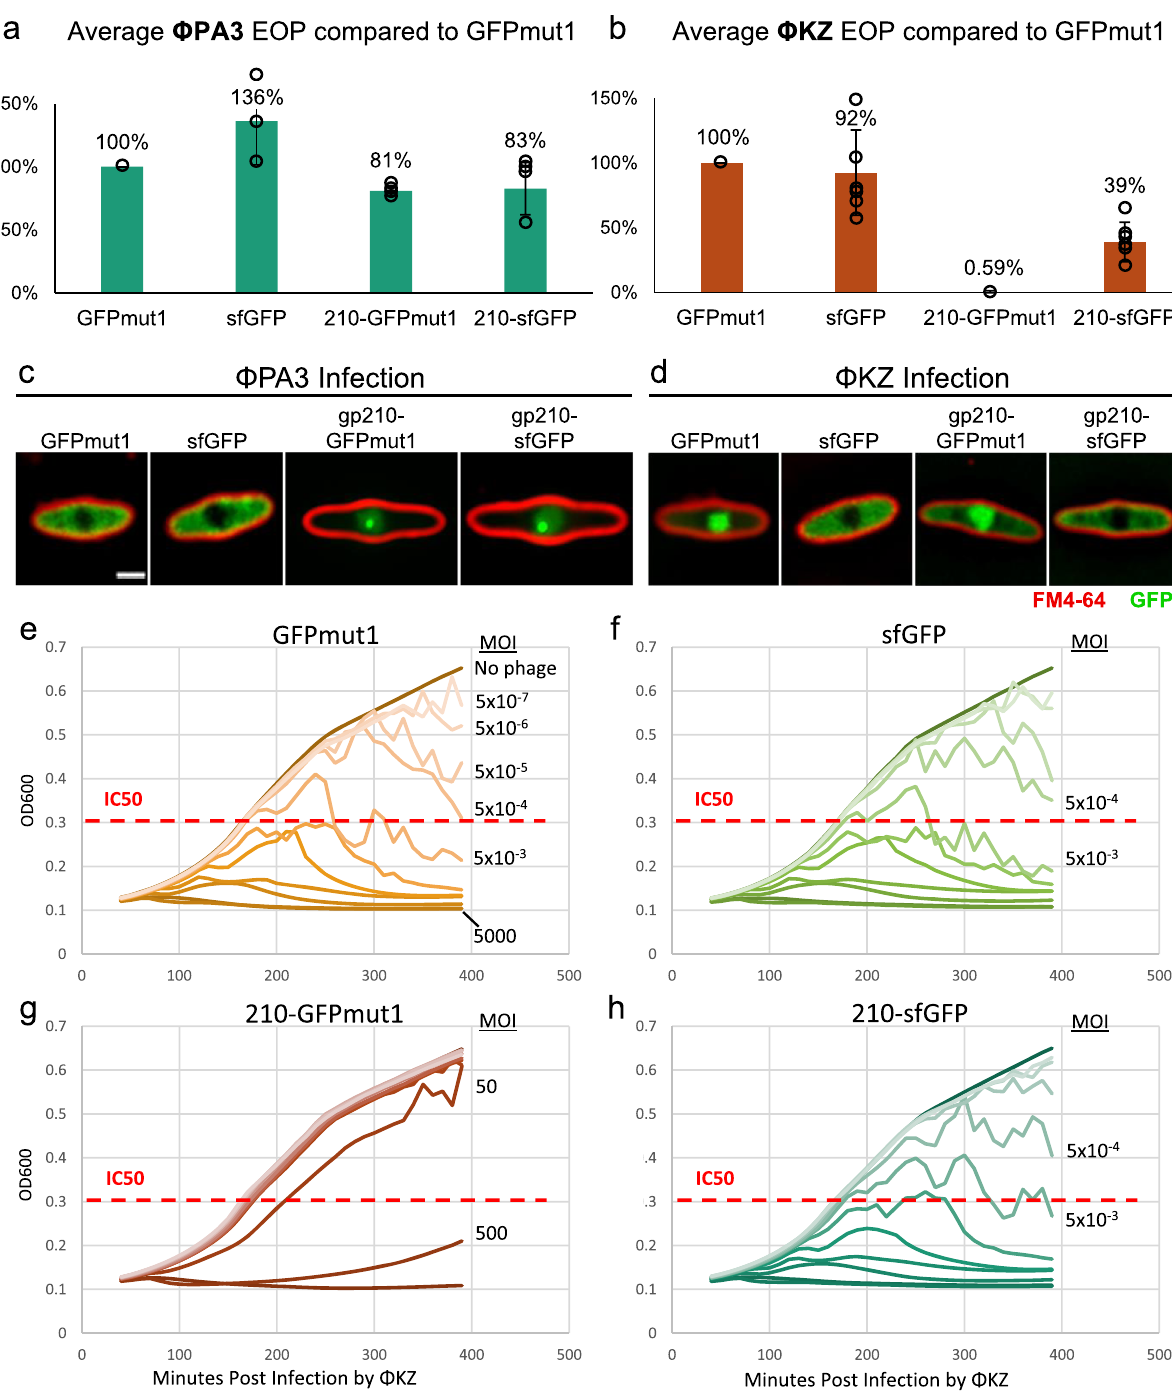
Fig. 4 A nuclear incompatibility determinant impairs phage fi tness. a Ef fi ciency of plating (EOP) relative to GFPmut1 for Φ PA3 in cells expressing the indicated fusions with 1% arabinose. The number of independent replicates, n , equals 4 (GFPmut1), 3 (sfGFP), 4 (gp210-GFPmut1), and 4 (gp210-sfGFP). Error bars equal standard deviation. b EOP relative to GFPmut1 for Φ KZ in cells expressing the indicated fusions with 1% arabinose demonstrate a 99.4% decrease in viable Φ KZ with gp210-GFPmut1 in the nucleus. The number of independent replicates, n , equals 7 (GFPmut1), 6 (sfGFP), 6 (gp210-GFPmut1), 6 (gp210-sfGFP). Error bars equal standard deviation. c , d GFP fusions (green) and FM4-64 stained cell membranes (red). Individual data points are shown as circles. c GFPmut1 and sfGFP localize to the cytoplasm during Φ PA3 infections. gp210-GFPmut1 and gp210-sfGFP localize to the nucleus and form puncta during Φ PA3 infections. d sfGFP and gp210-sfGFP localize to the cytoplasm of Φ KZ infected cells. GFPmut1 and gp210-GFPmut1 localize to the nucleus of Φ KZ infected cells. e – h Determination of Φ KZ IC50 (red dotted line) for cells expressing control proteins GFPmut1 or sfGFP ( e , f ) or fusions to gp210 ( g , h ) as indicated by measuring cell growth (OD 600 ) over 6.5 h of infection. Ten-fold serial dilutions of phage were added to cells resulting in a multiplicity of infection (MOI) ranging from 5000 to 5 × 10 − 7 as shown in ( d ). All growth curves represent an average of eight independent trials. For the sake of clarity, only the MOIs that indicate the IC50 are shown for ( f – h ). Source data are provided as a Source Data fi le.